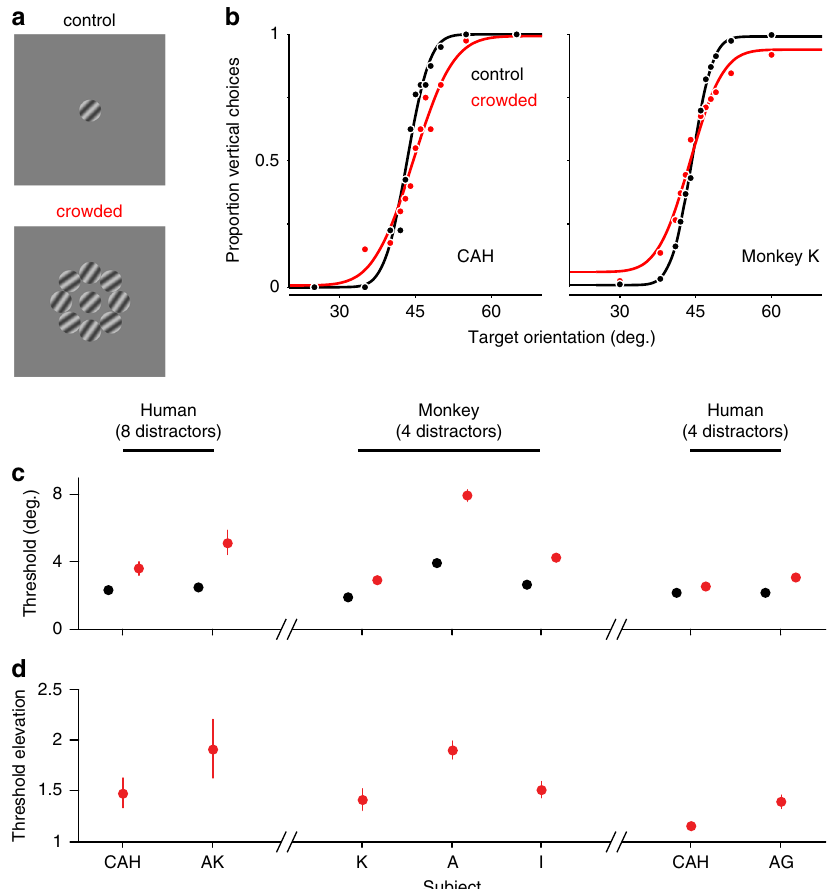
Fig. 1 Psychophysical measures of crowding. a Example task displays, for targets alone (top) and with distractors (bottom). b Example psychometric functions for one human (left) and one monkey observer (right), for targets alone (black) and with distractors (red). Curves are cumulative normal fi ts to the data. c Subjects ’ discrimination thresholds for targets alone (black) and with distractors (red; all points represent mean ± s.e.m. across sessions). Left: human performance for stimuli matched to physiological experiments. Center: monkey performance on similar stimuli (see Methods section). Right: human performance on stimulus parameters matched to those used for monkeys. d Threshold elevations under crowding (ratio of thresholds with distractors compared to targets alone; points represent geometric mean ± s.e.m. across sessions). Source data are provided as a source data fi For each array implant, we fi rst mapped the spatial receptive fi eld of each sampled neuron, and then centered all subsequent stimuli over the aggregate receptive fi eld of the population (Fig. 2a). Receptive fi elds were located in the lower visual fi eld, at an eccentricity of 3 – 5°.